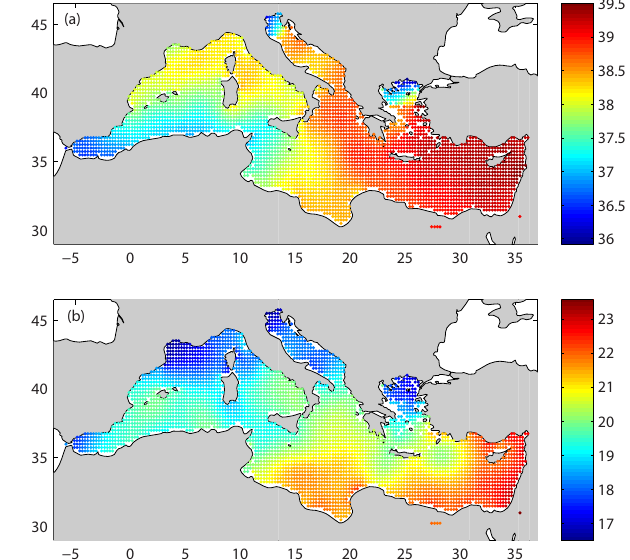
Figure 6. The 7-year averages (2005–2012) of (a) sea surface salinity and (b) sea surface temperature climatological fields of the WOA13 (Locarnini et al., 2013; Zweng et al., 2013).